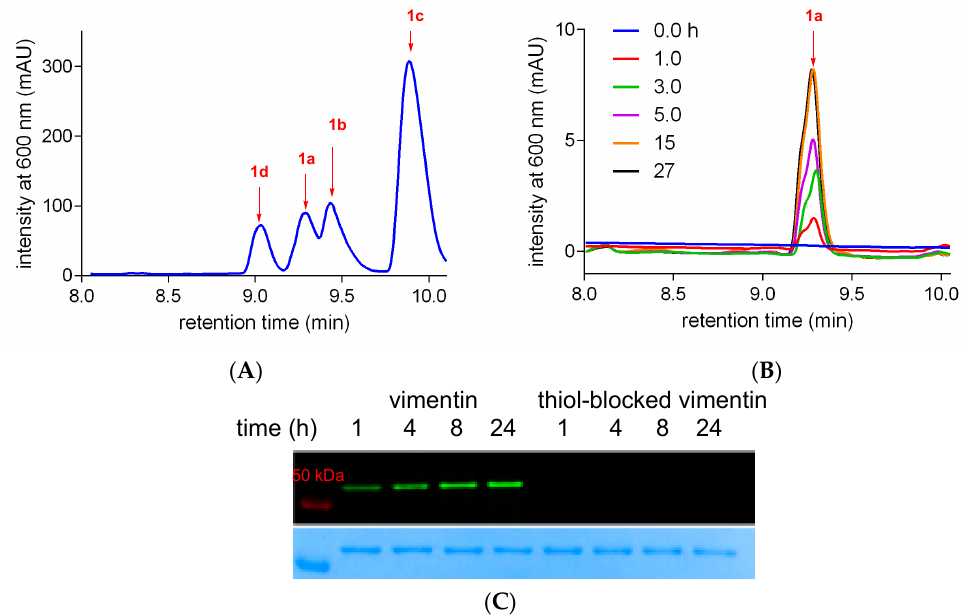
Figure 4. High-performance liquid chromatography (HPLC) analysis of ( A ) 200 μ M of each amino-acid-conjugate standard 1a – d in 50 mM pH 8.0 HEPES buffer; ( B ) kinetic study for 200 μ M of MHI-148 with 200 μ M of each amino acid ( N -acetyl- L -Cys, N -acetyl- L -Tyr, N α -acetyl- L -Lys, N ε -acetyl- L -Lys, and L -proline) in 50 mM pH 8.0 HEPES buffer incubating at 37 °C; ( C ) NIR fluorescent gel image of vimentin or 6-MA-blocked vimentin (1 μ M) incubated with MHI-148 (1 μ M) in 50 mM pH 7.24 HEPES buffer at different incubation times.